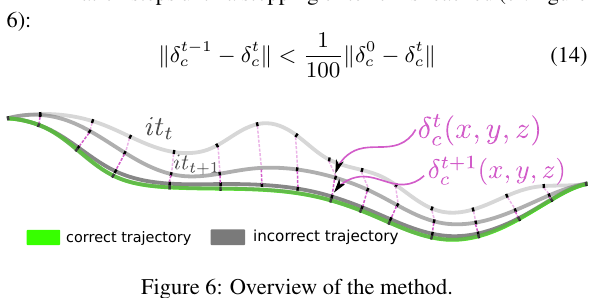
Figure 6: Overview of the method.